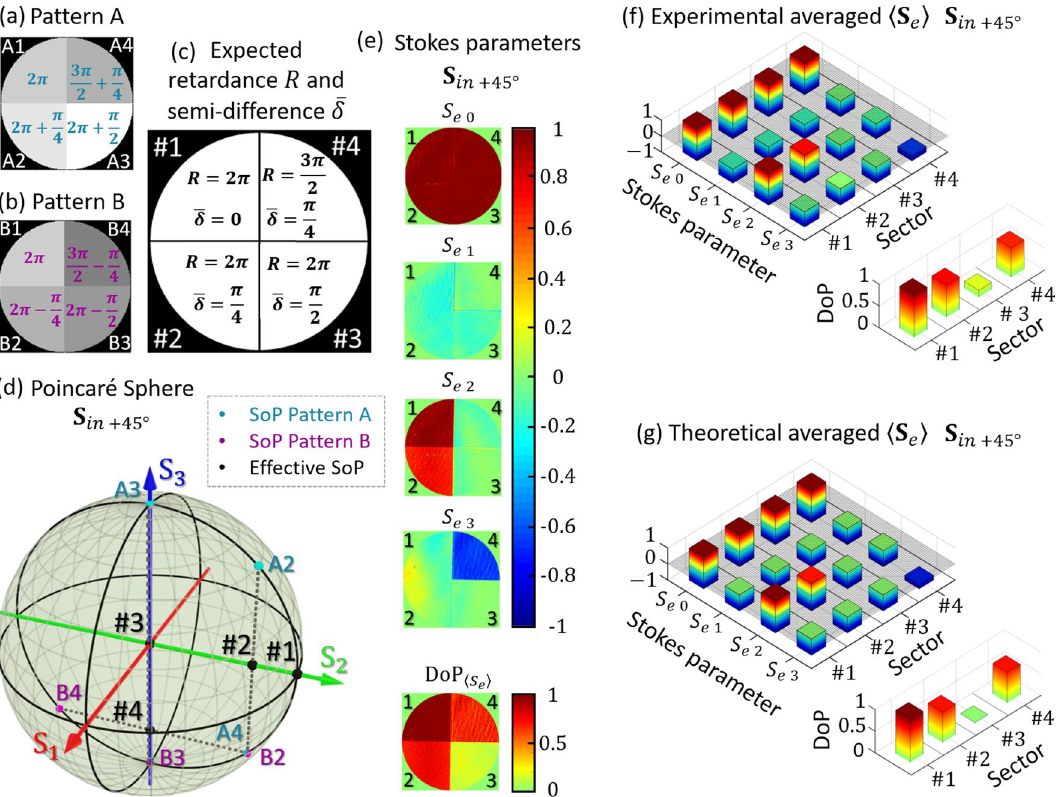
Figure 4. ( a , b ) Switching phase-pattern images. ( c ) Expected retardance and semi-difference. ( d ) Location 1, 2, 3, 4 on the Poincaré sphere for a of the theoretical effective SoP for each j pattern sector where j = 45 ◦ . The points A- j and B- j indicate the SoP of the individual phase pattern. ( e , f ) linear incident SoP at + S Experimental output effective Stokes parameters e � = ( S e 0 , S e 1 , S e 2 , S e 3 ) and their respective effective DoP � 45 ◦ . ( g ) Corresponding expected theoretical Stokes parameters and when the incident beam is polarized at +